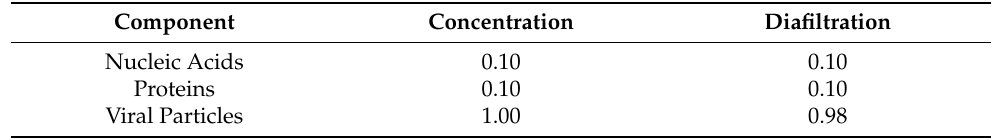
Table 5. Rejection coefficients for tangential flow